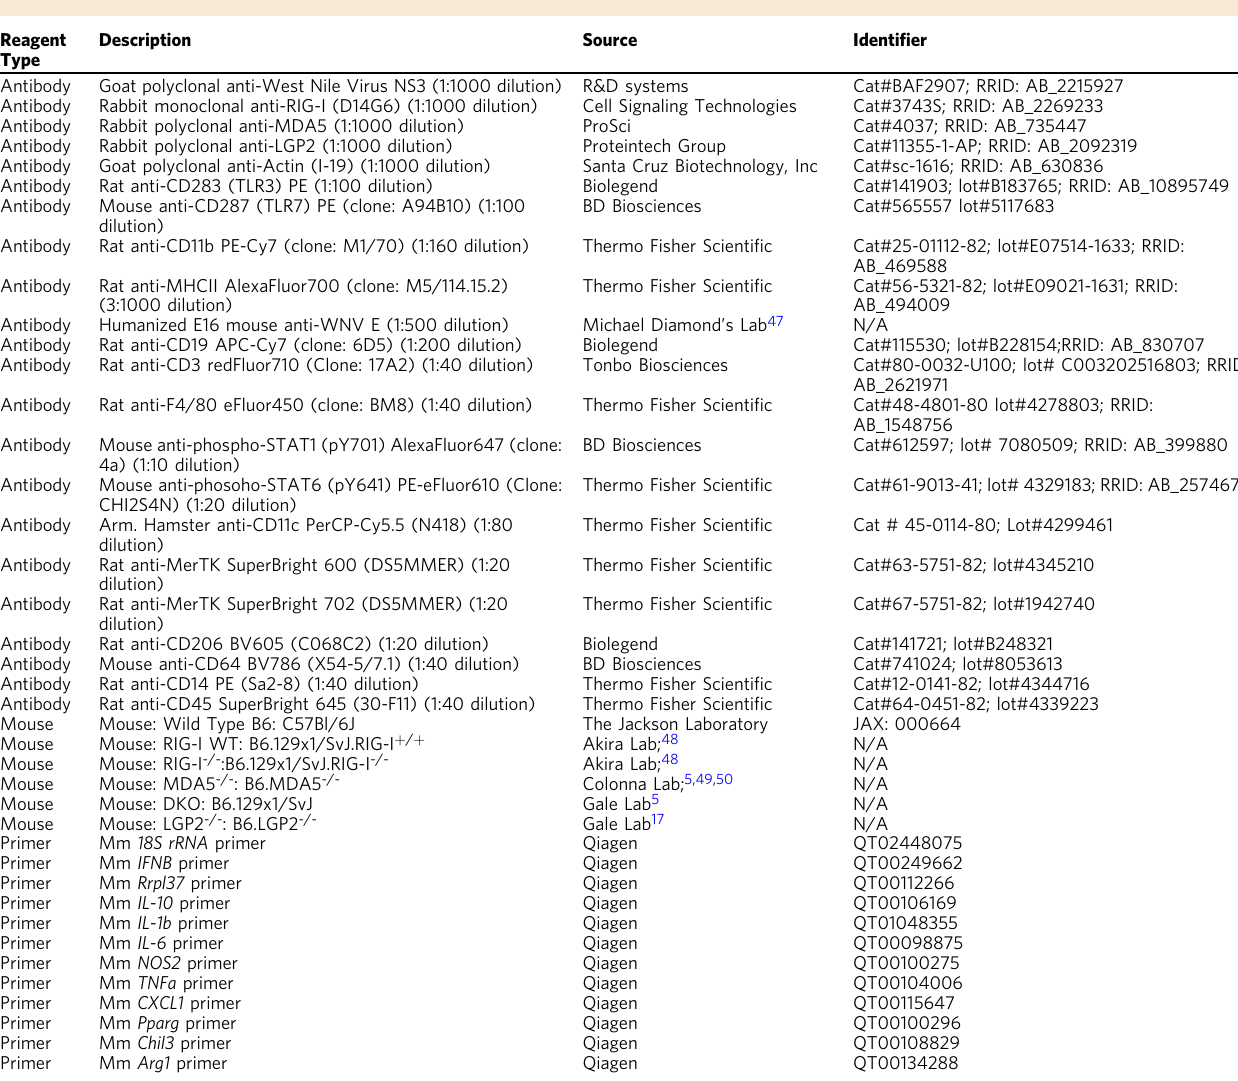
Table 1 Reagents table Reagent